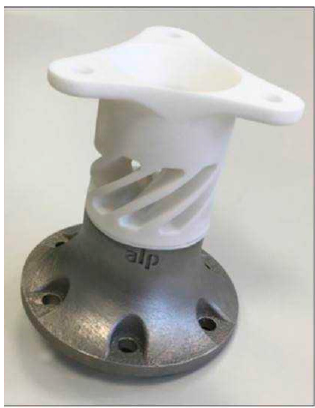
Figure 11. Dynamic overload clutch fabricated by the new polymer–metal hybrid process.